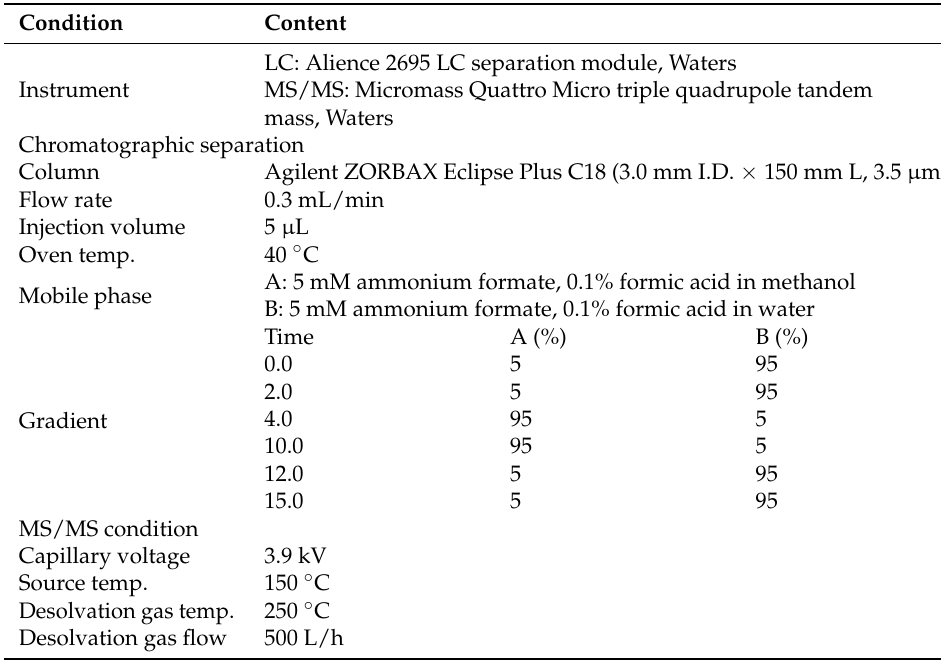
Table 2. Analytical conditions for the determination of the tested analytes in various